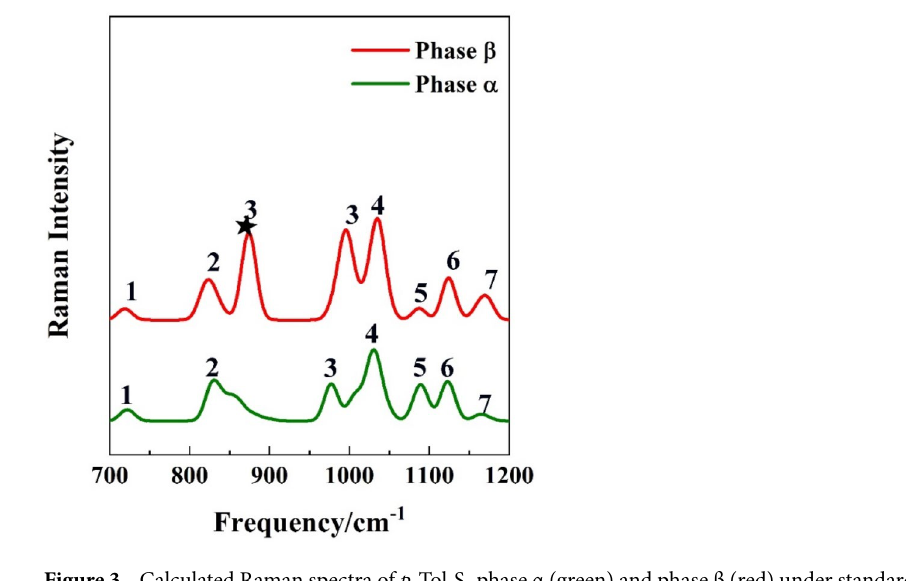
Figure 3. Calculated Raman spectra of p -Tol 2 S 2 phase α (green) and phase β (red) under standard atmospheric